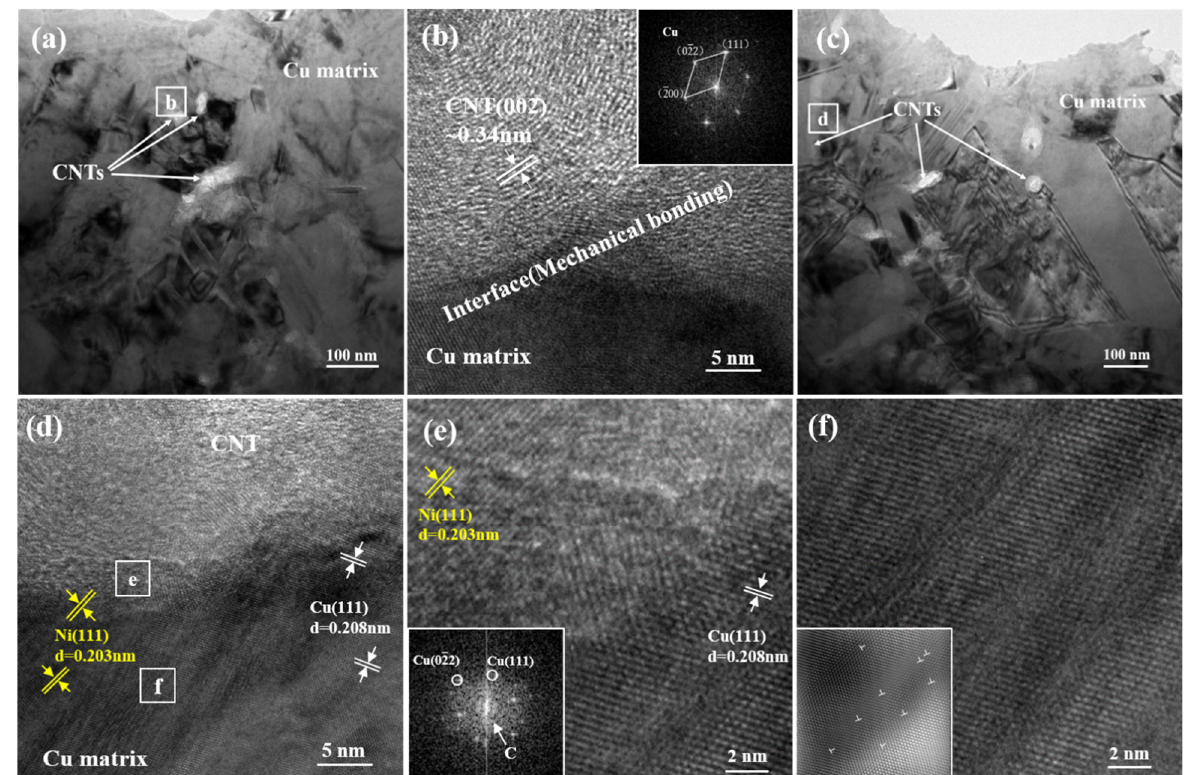
Figure 6. TEM observation of Cu-Ni/CNTs composites before and after heat treatment; ( a ) bright-field image before heat treatment ( b ) enlarged image from the box area in ( b ); ( c ) bright-field image after heat treatment ( d ) enlarged image from the box area in ( c ); ( e , f ) are corresponding to the high-resolution images of the marked area in ( d ).